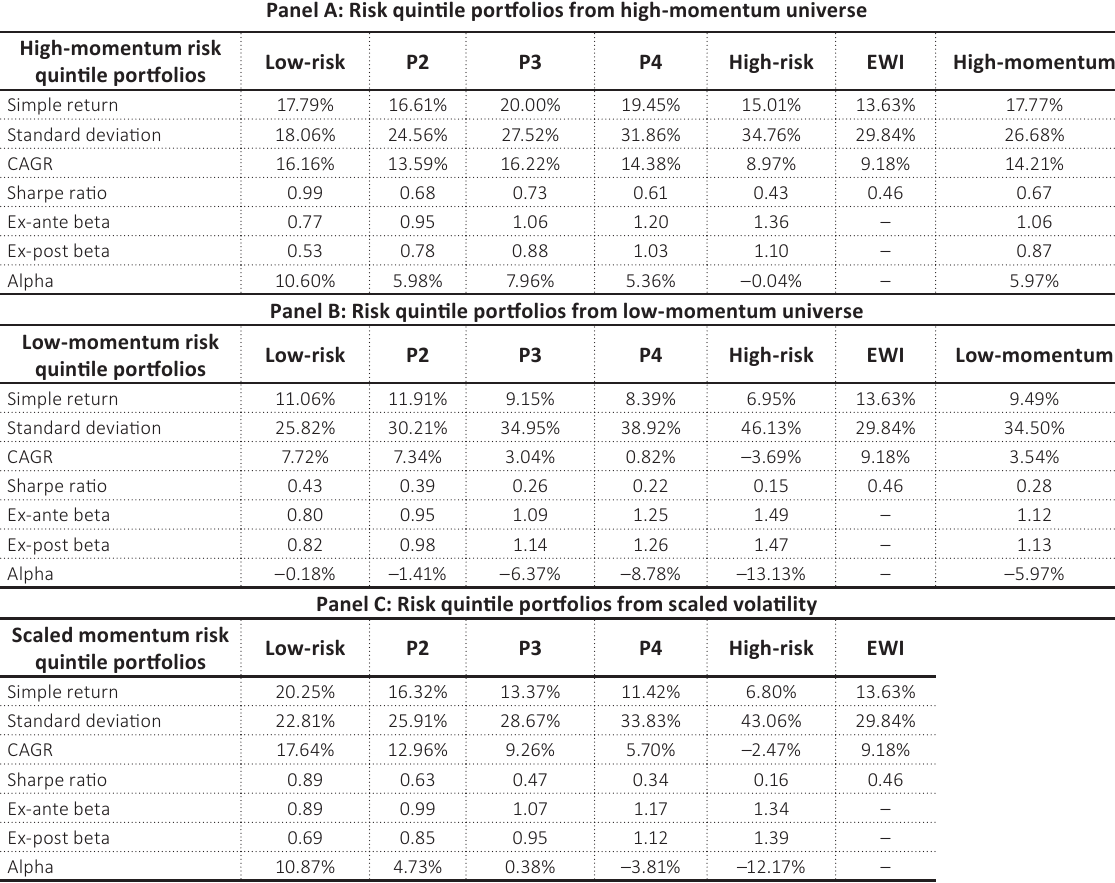
Table 5. Performance statistics of momentum blended risk-quintile portfolios Panel A: Risk quintile portfolios from high-momentum universe